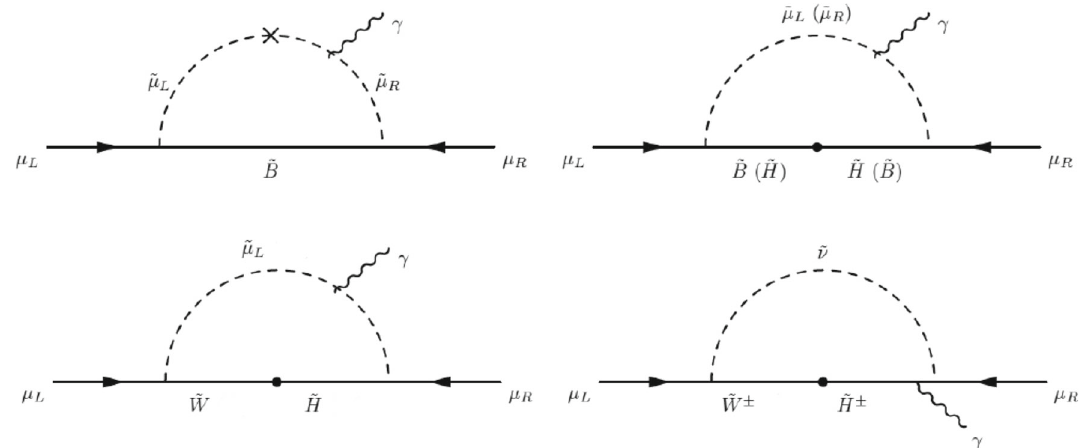
Fig. 1 The leading contributions to the muon g − 2 through neutralino and chargino loops. The cross in the top-left diagram denotes the chi- rality flip between the left- and right-handed smuons, while the dots in